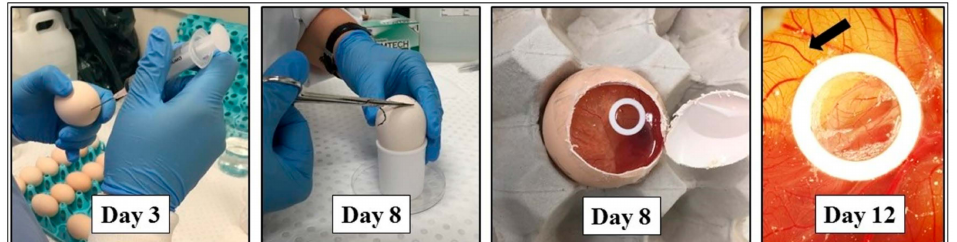
Figure A11. Illustration of the grafting protocol. The following sequential steps are shown: Extraction of the egg white on ED3. Opening of the egg on ED8. Grafting of the tested samples on the CAM on ED8. The cell suspension grafting is shown; a sterile white rubber ring taken from a 1.5 mL cryovial (inner diameter 8 mm) is used to prevent the leakage of the suspension. The last (right) image shows the same egg on ED12. The arrow shows a bifurcation of a blood vessel as a preferential grafting